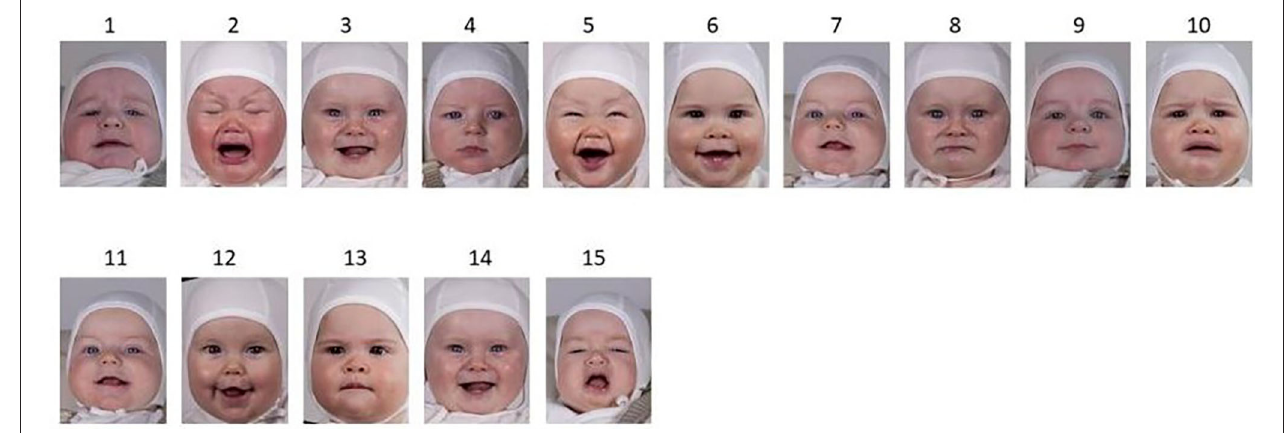
FIGURE 2 | Example of a series from the Face Recognition Task. Top line: stimulus images, positive (happy) and negative (sad) valence. Bottom line: presented images for recognition. 11 = 7 (hit), 12 = face not seen, expression (happy) seen, 13 = face seen, expression (neutral) not seen, 14 = 3 (hit), 15 = face not seen, expression (angry) not